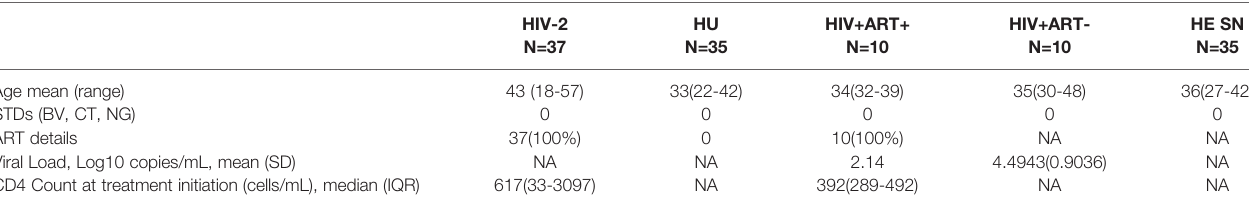
TABLE 1 | Demographic characteristics of Study Populations